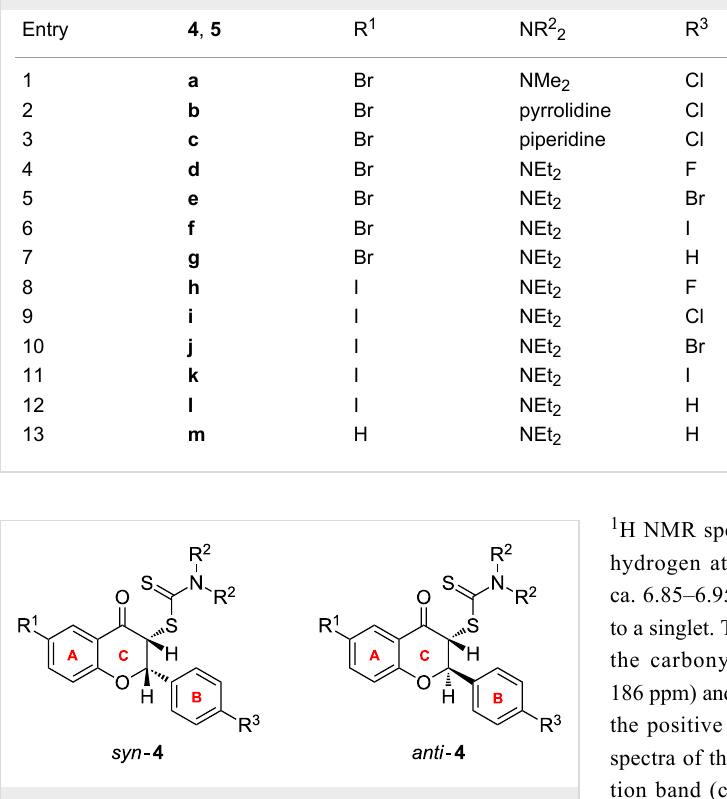
from the anti -isomer, appear between 5 ppm and 6 ppm and correspond to the hydrogen atoms H2 and H3. These isomers can be distinguished by calculating the coupling constants, which are found to be ca. 4 Hz for the syn and ca. 9 Hz for the anti -isomers.